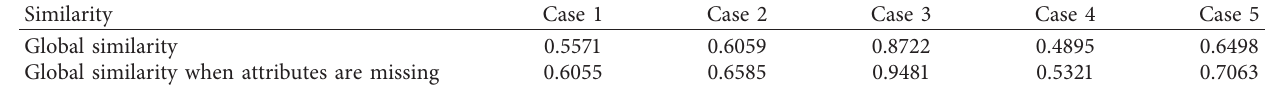
Table 3: The similarity between the target case and the source case.